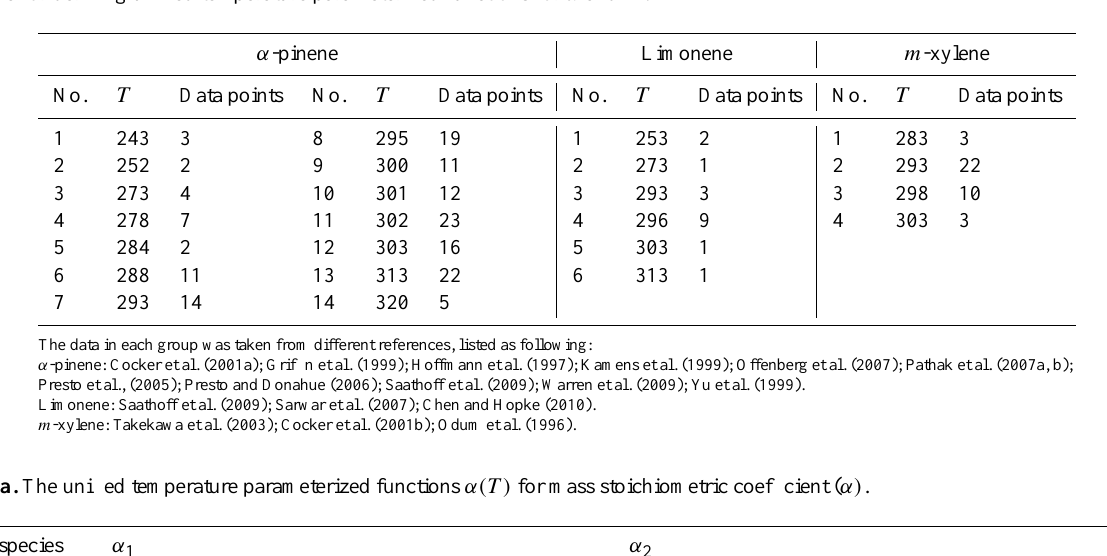
+ 0 . 0659 · T − 40 . 296 α 2 = 6186 . 77 T